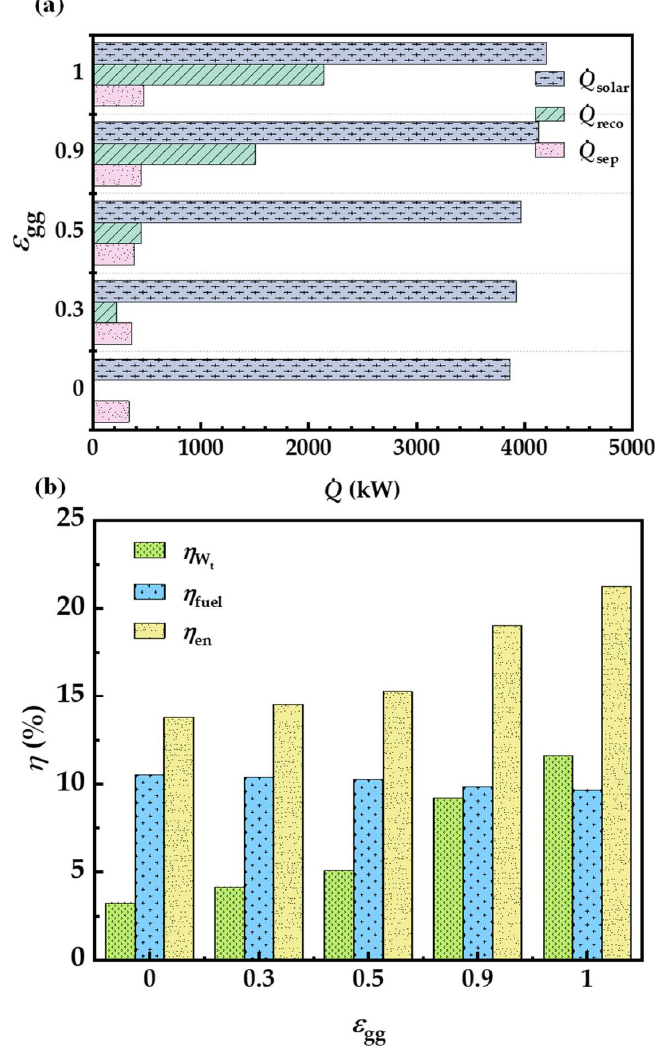
ɺ ɺ . . . ɺ Q , Q , and Q , ( b ) effect of ε gg on h Q solar , Q reco , and Q sep , ( b ) effect of ε gg on η fuel , η W solar reco sep